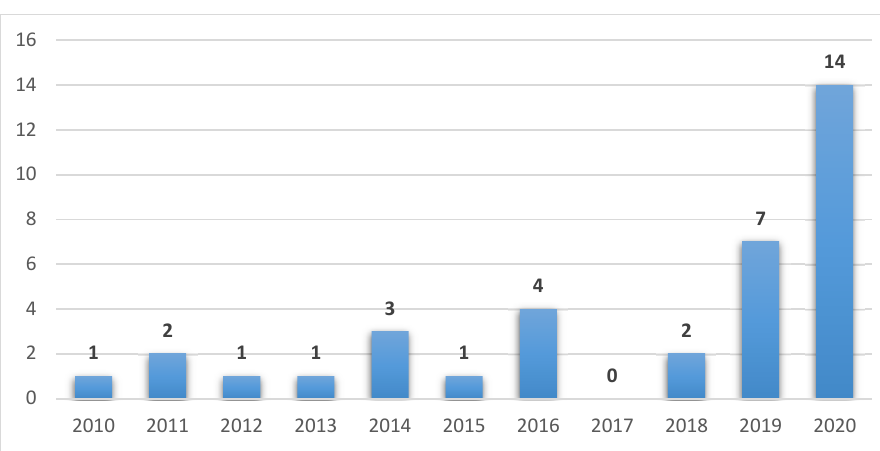
Fig. 14. Number of multi-objective HFS articles according to